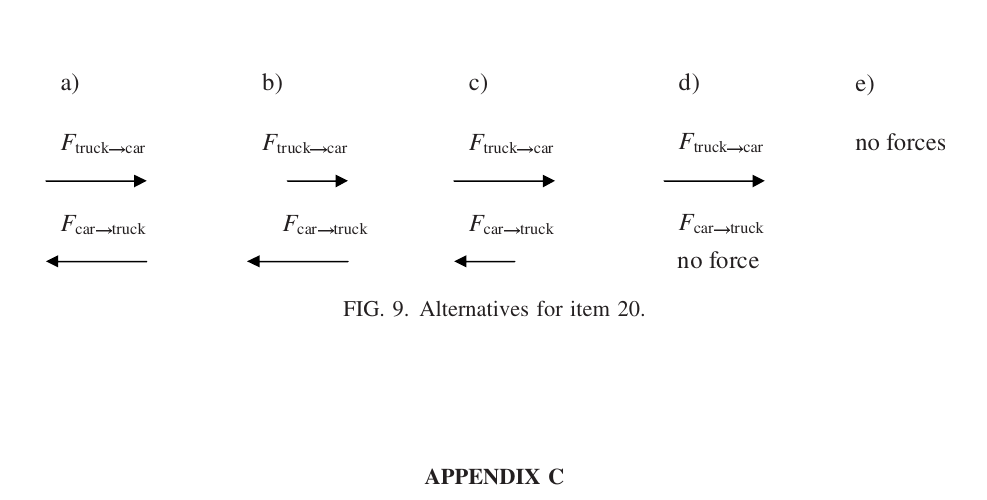
FIG. 8. Alternatives for item 11.